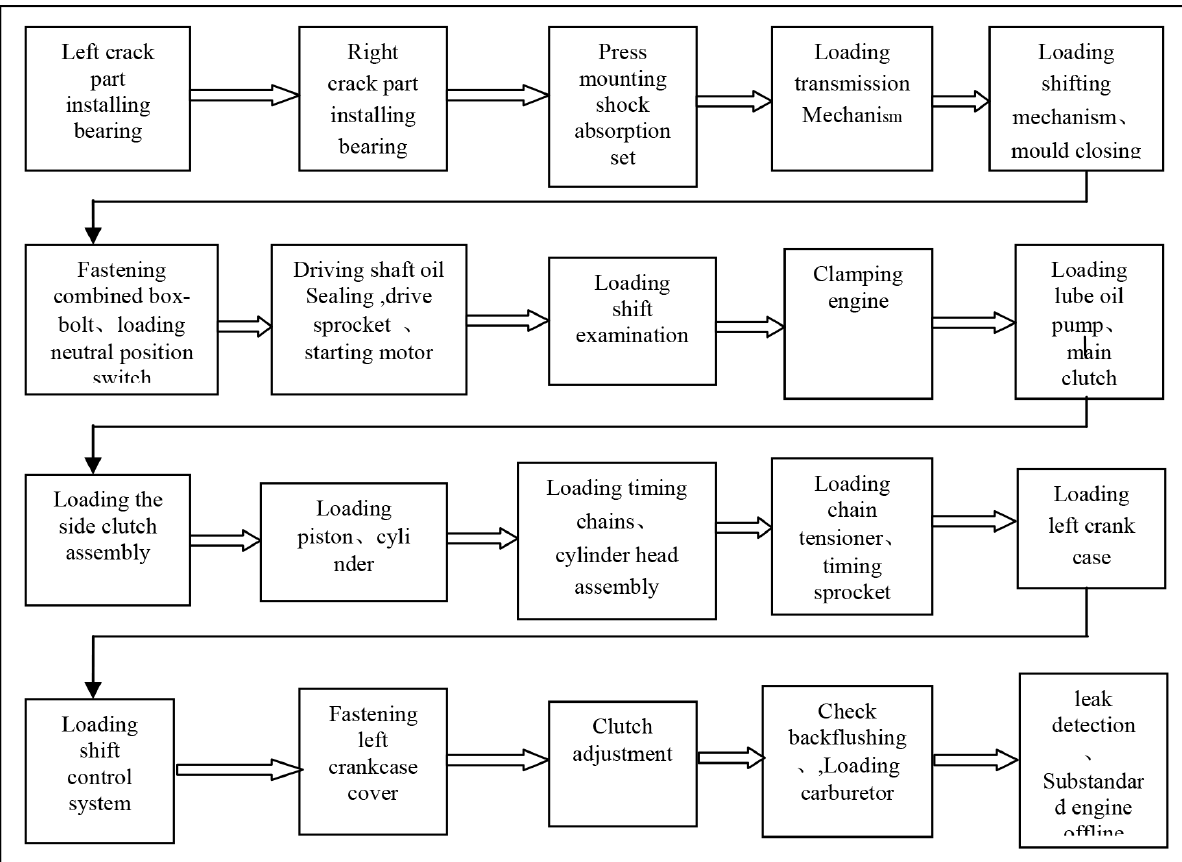
Figure 1. The total assembly line flow chart of